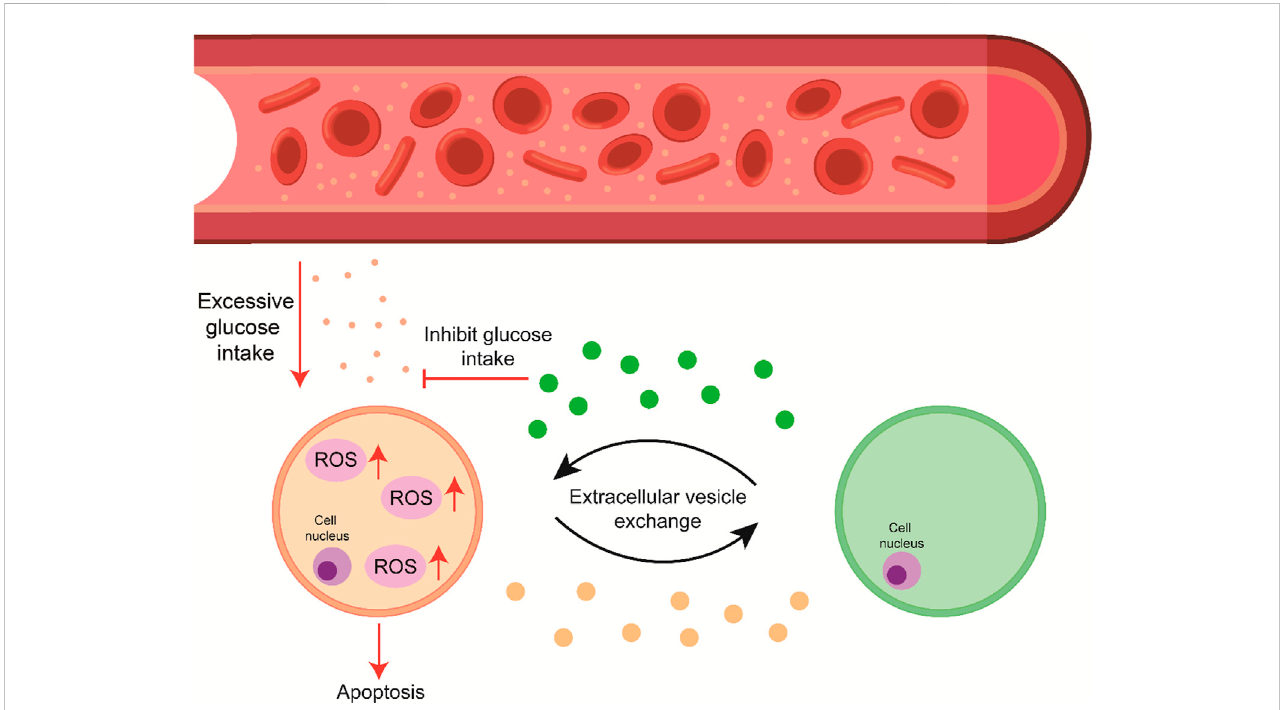
FIGURE 1 High blood glucose levels lead to ROS generation and accumulation, and the signal exchange through the cell – EV – cell axis promotes cell survival by suppressing